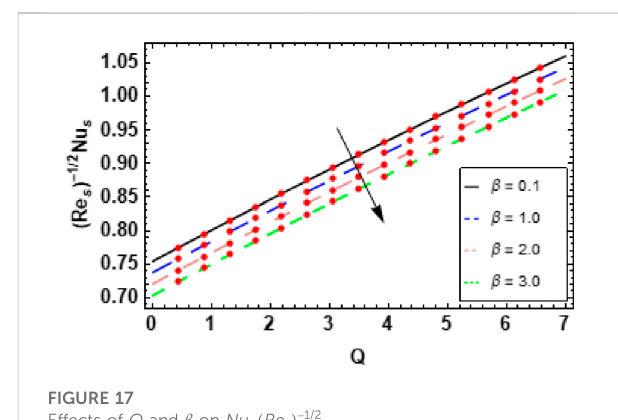
FIGURE 15 In fl uences of γ and M on skin friction.